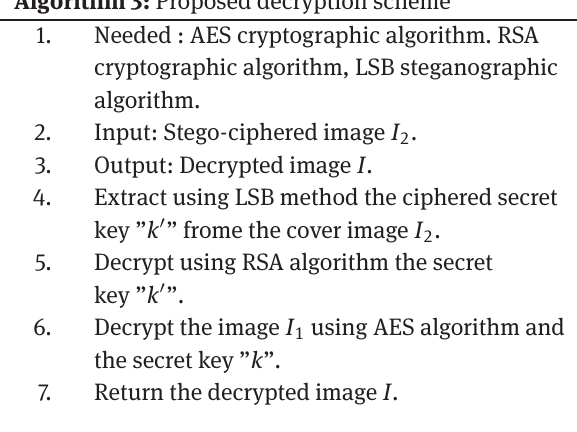
Algorithm 3: Proposed decryption scheme